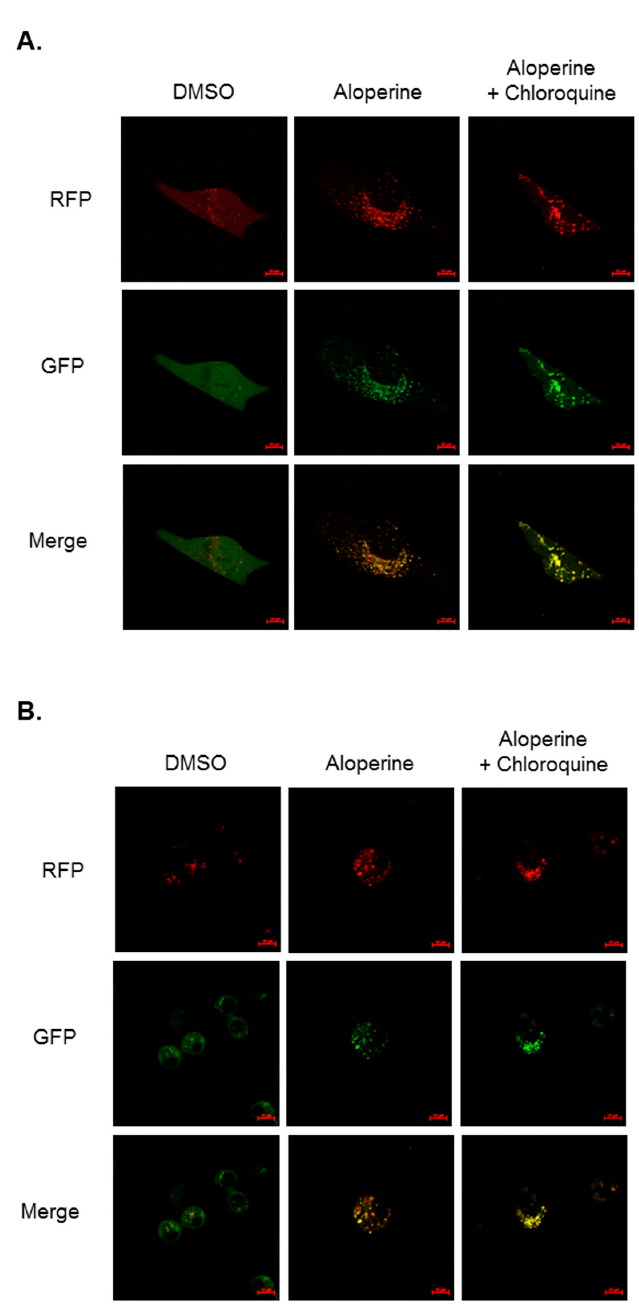
Figure 4. Induction of autophagic flux in human anaplastic thyroid cancer cells following aloperine treatment. ( A ) KMH-2 and ( B ) IHH-4 cells expressing pmRFP-EGFP-LC3 were subjected to aloperine (200 µ M) treatment for 24 h with or without 5 µ M chloroquine to determine autophagosome / lysosome fusion. Autophagosome ( yellow ) and autolysosome ( red ) puncta increased in the aloperine group, and most puncta were yellow (autophagosome) in the chloroquine combination group. DMSO was used as a negative control.